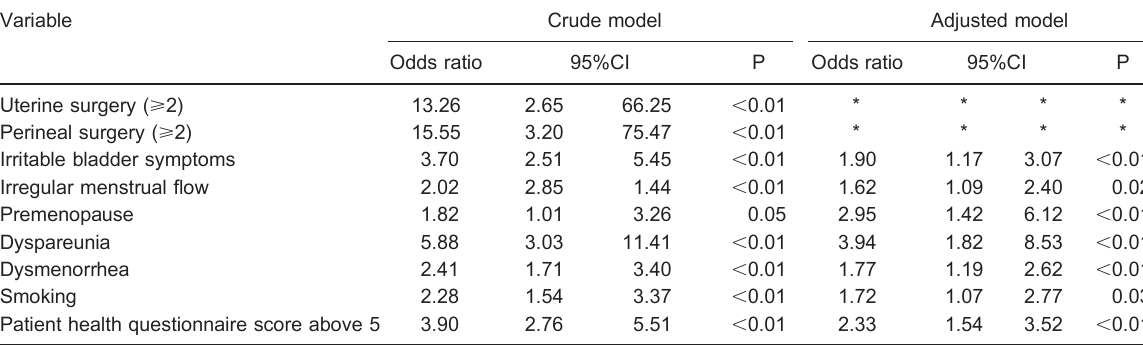
Table 4. Multivariate analysis of the study